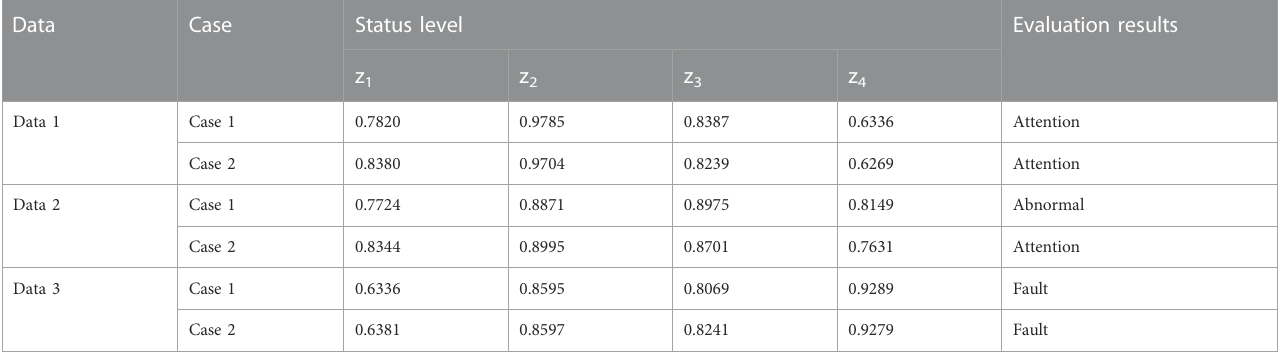
TABLE 8 Comparison results of different weighting